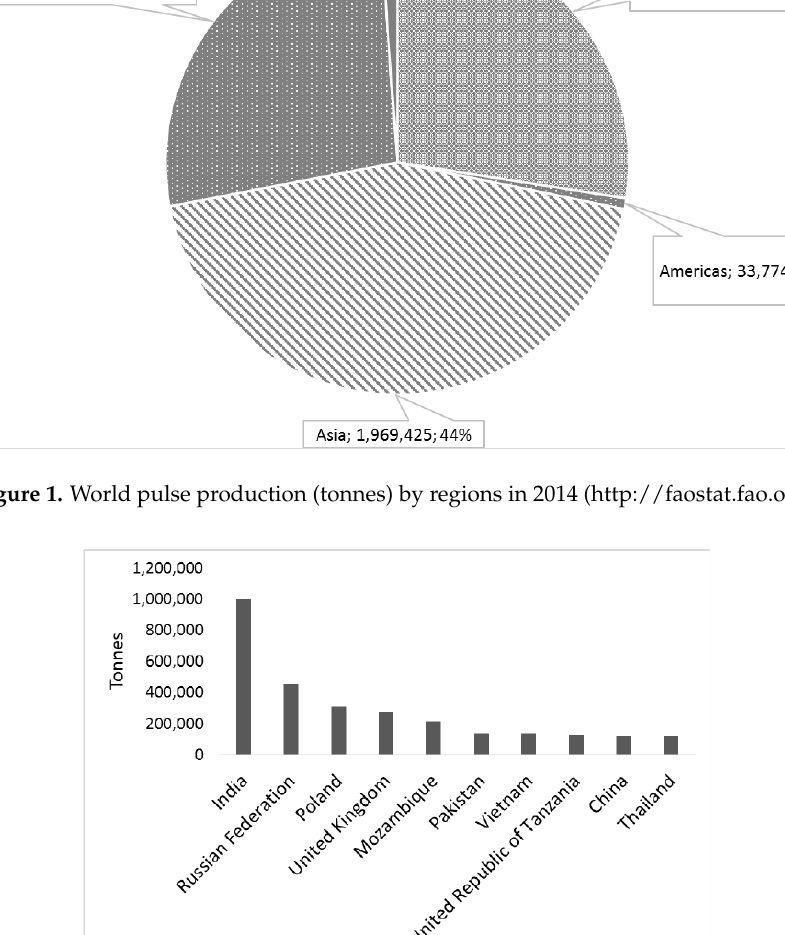
Table 1. Nutritional composition of common bean ( Phaseolus vulgaris L.), cranberry, mature seed, raw *.